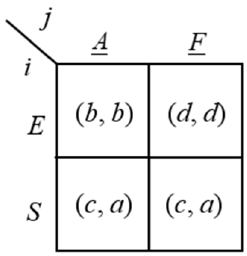
Figure 5. Original game G with one equilibrium confirmed agreement that is not played.